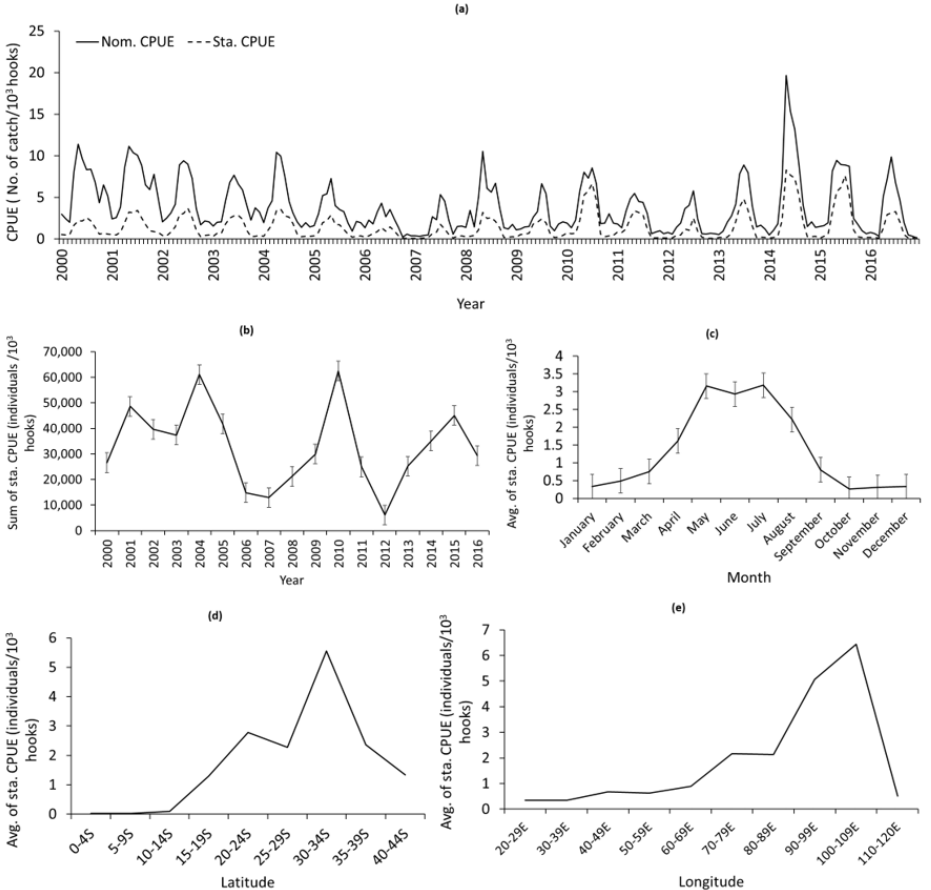
Figure 2. ( a ) Time series of nominal (nom.) and standardized (sta.) catch per unit effort ( CPUE ) data and ( b ) the changes in the sum of standardized CPUE , yearly. Average of standardized CPUE ( c ) monthly, ( d ) latitudinally, and ( e )